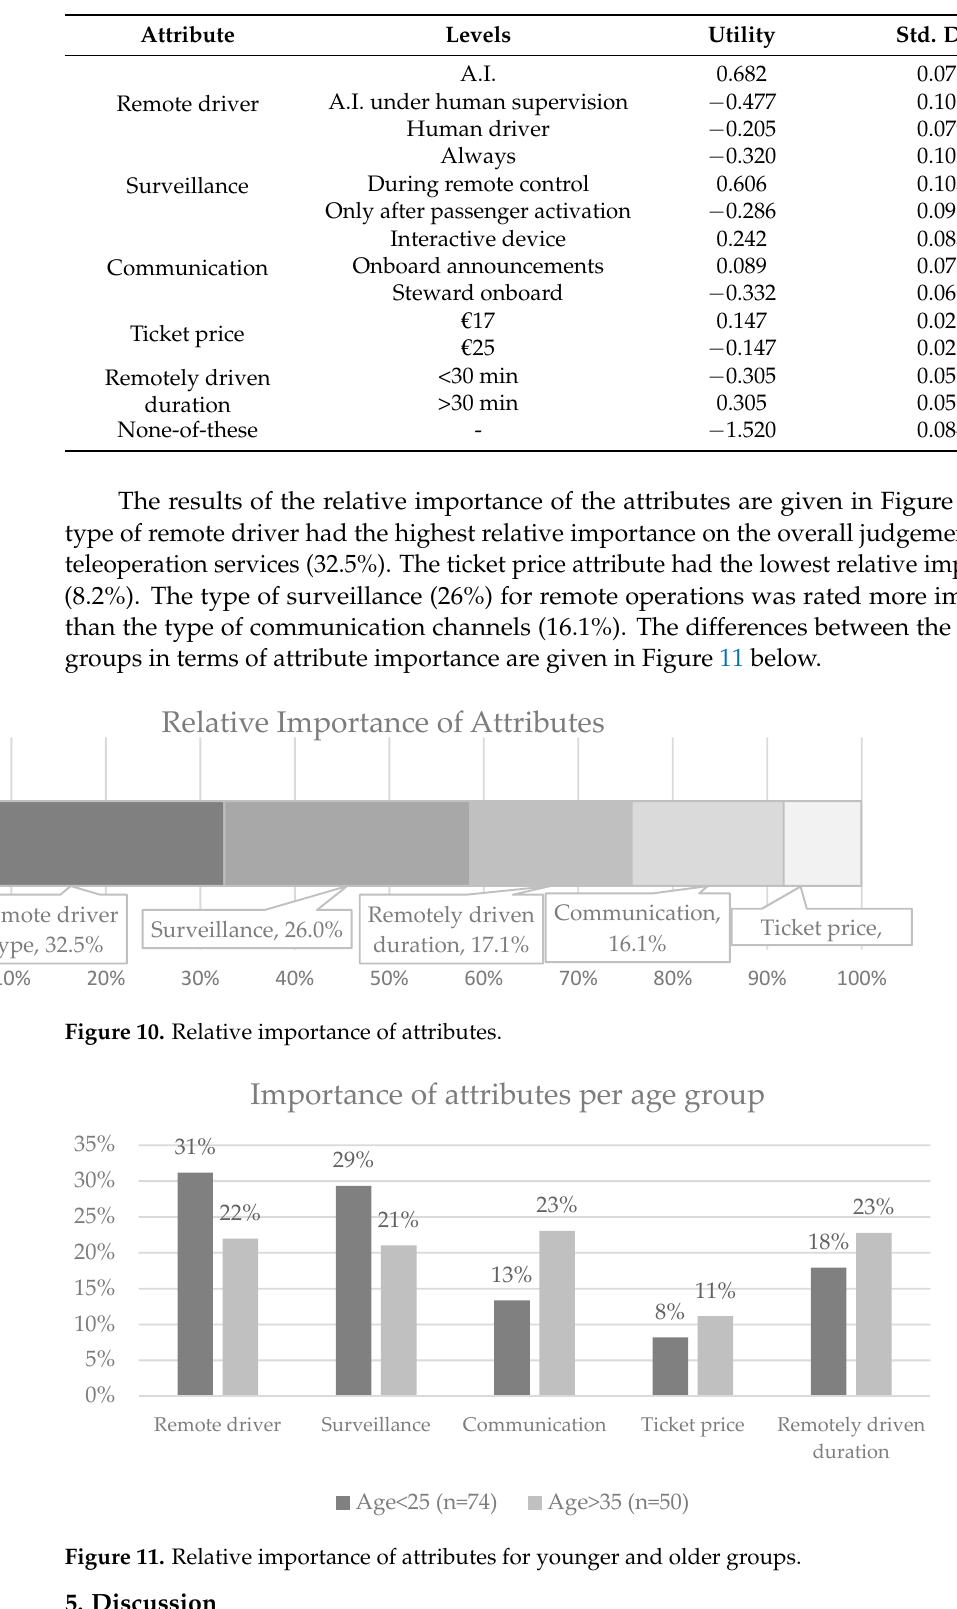
Table 2. Aggregated utilities of CBC attribute levels.